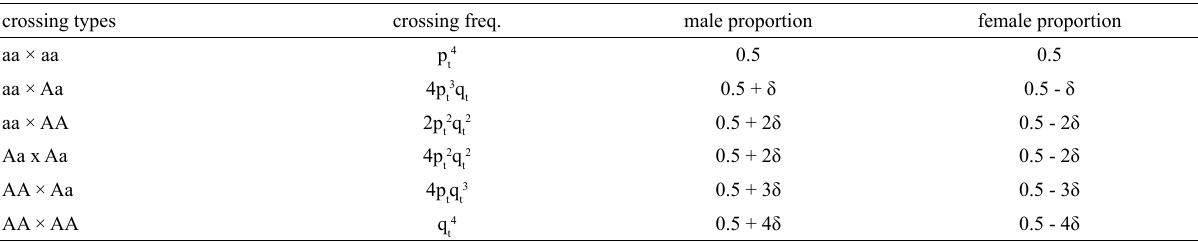
Table 1 ‒ Population frequencies of crossing types and progeny sex proportions (model 2). A is an autosomal mutant allele responsible for a distortion in the sex-ratio depending on the number of copies present in the parental pair. crossing types crossing freq.